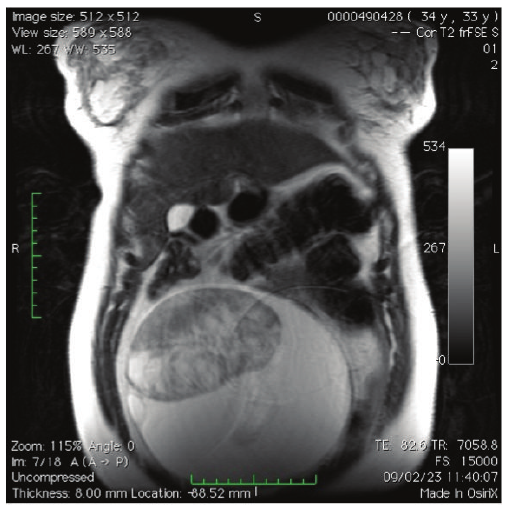
Figure 3: MRI showing the solid component of the adnexal